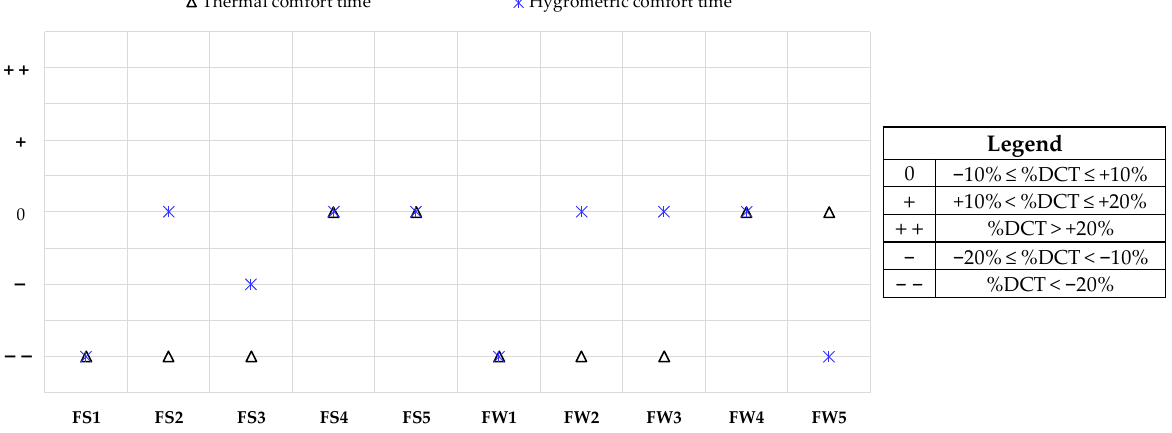
Figure 8. Symptoms’ relevance to the selected faults in terms of thermal-hygrometric comfort.